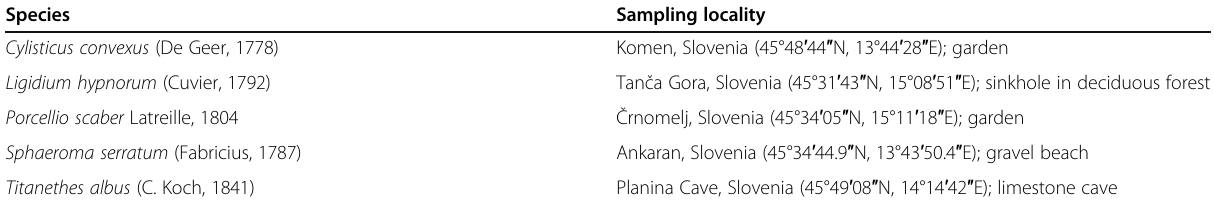
Table 1 Sampling localities of the isopods used in this study Species Sampling locality Cylisticus convexus (De Geer,